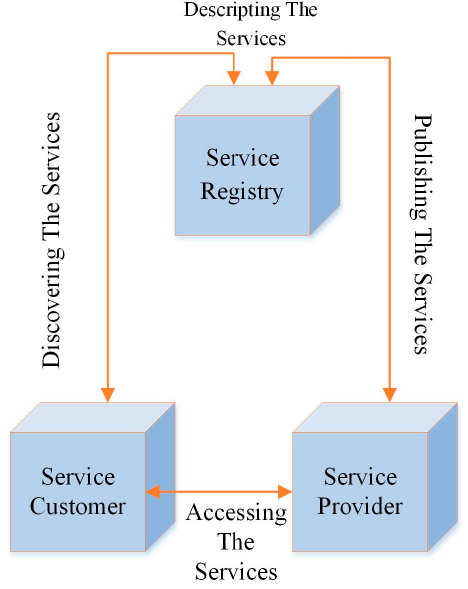
Figure 3. Service-Oriented Architecture (SOA) [15].